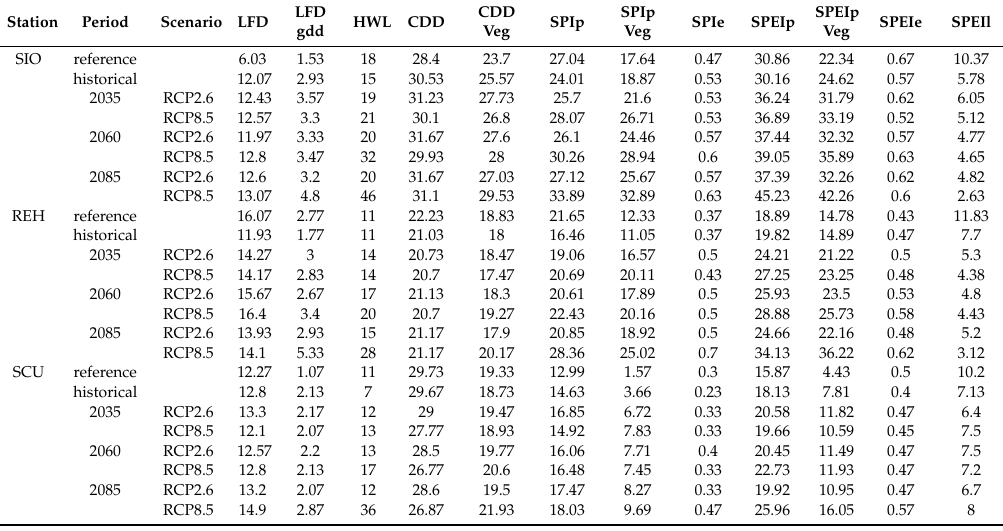
Table A2. Median values for class B indices as represented by observations (reference) and by the quantile-mapped CH2018 data for all time periods (historical, 2035, 2060 and 2085) and the two emission scenarios (RCP2.6 and RCP8.5) for the three representative stations SIO, REH and SCU. Station Period SIO